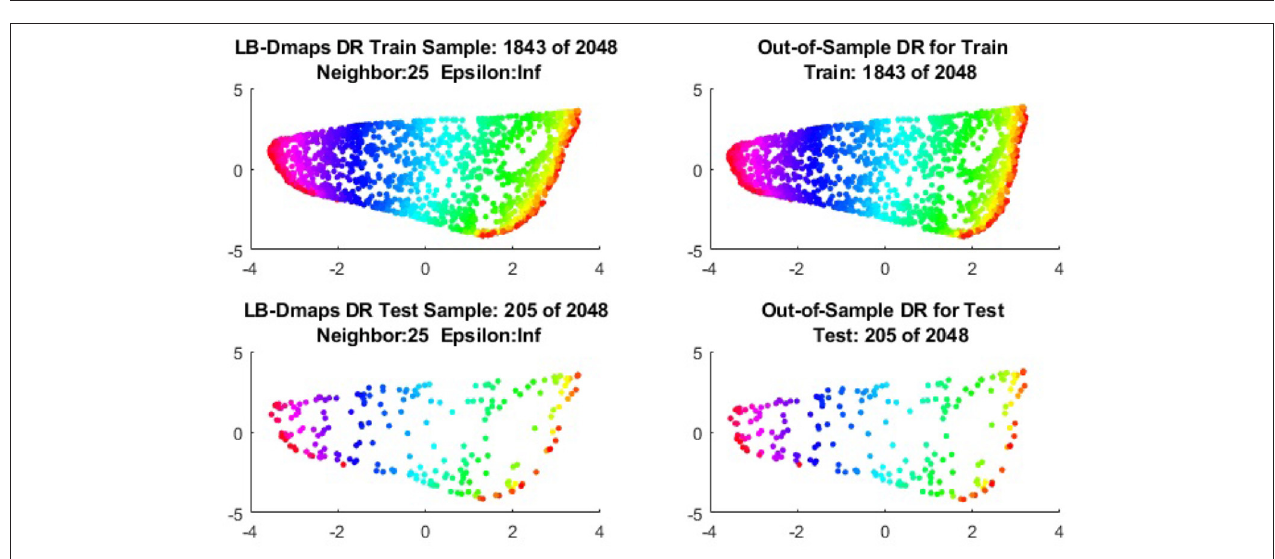
FIGURE 13 | Comparisons of DRs of training data and the testing data, respectively, for Swiss Roll.